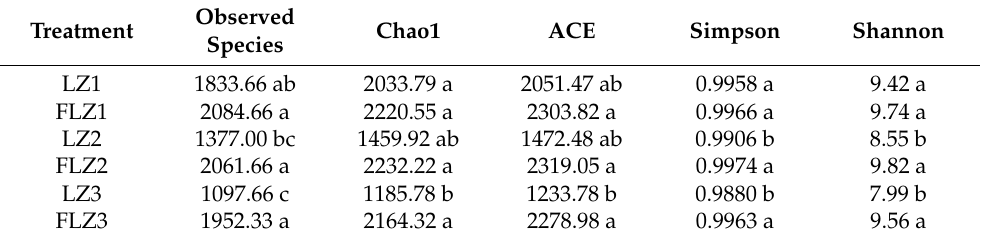
Table 4. Calculations of observed species, richness and diversity in different soil samples.